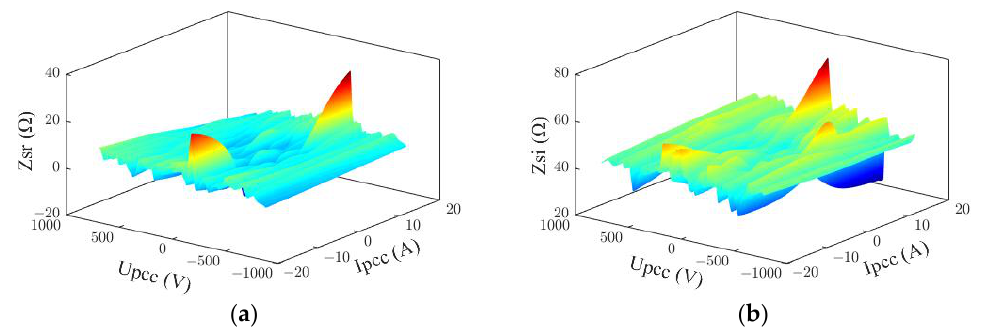
Figure 23. Results of method 3 in 7th harmonic. ( a ) Real part; ( b ) Imaginary part.